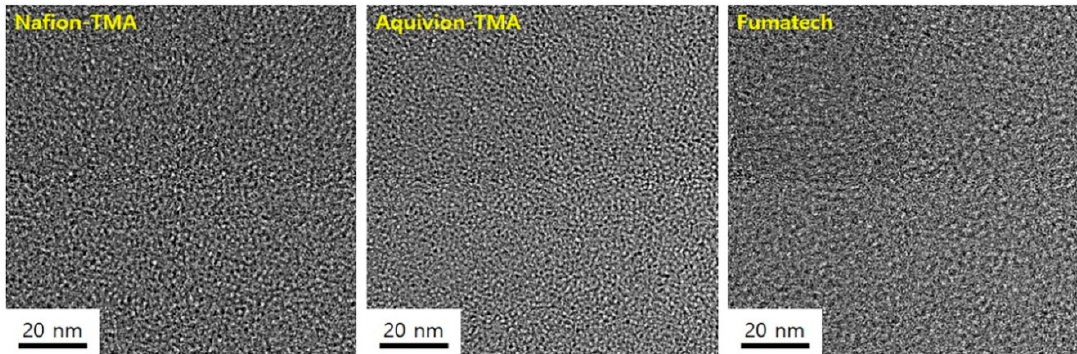
Figure 4. TEM images of the Nafion-TMA, Aquivion-TMA, and Fumatech membranes.